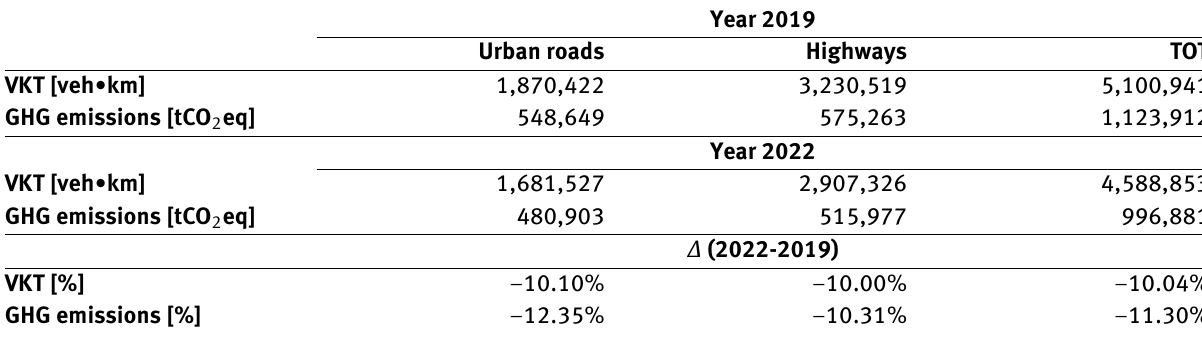
Table 4: Traflc simulation and GHG emissions calculations